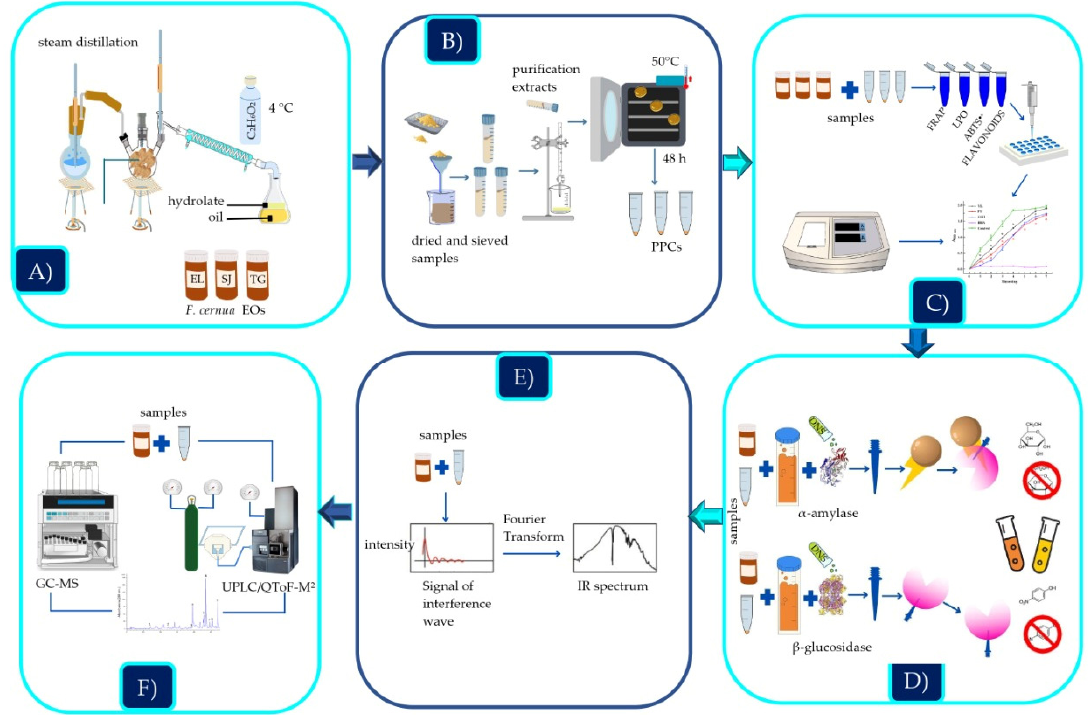
Figure 2. General experimental process: ( A ) extraction of EOs, ( B ) extraction of PPCs, ( C ) evaluation of antioxidant activity, ( D ) enzyme inhibition assays, ( E ) analysis by FTIR-ATR, ( F ) identification by GC/MS and UPLC/QToF-MS 2 .